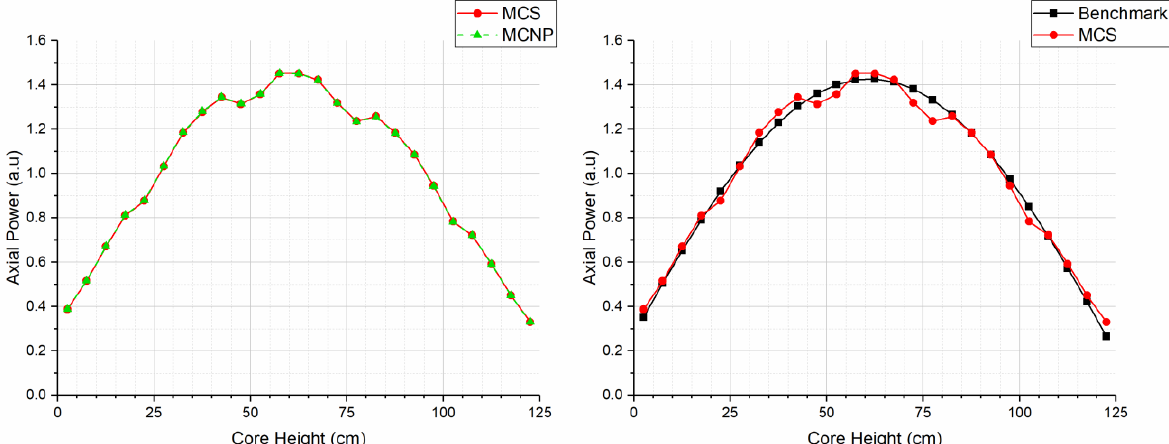
Figure 6. Comparison of relative axial power distribution: MCS against MCNP (left) & MCS against benchmark